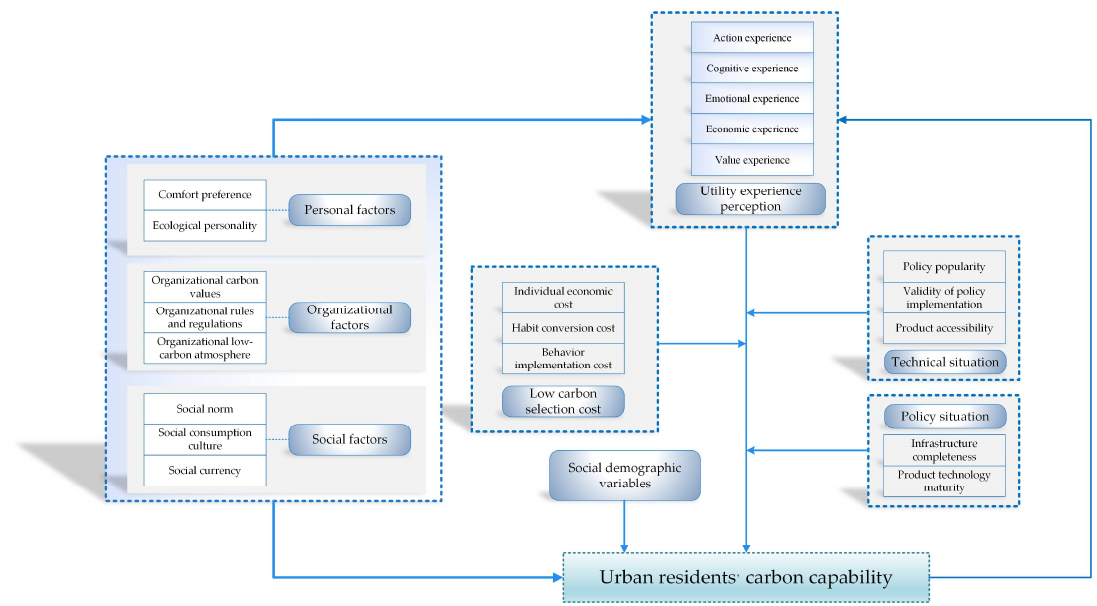
Figure 2. Comprehensive theoretical model of the mechanisms that drive the carbon capability of urban residents.